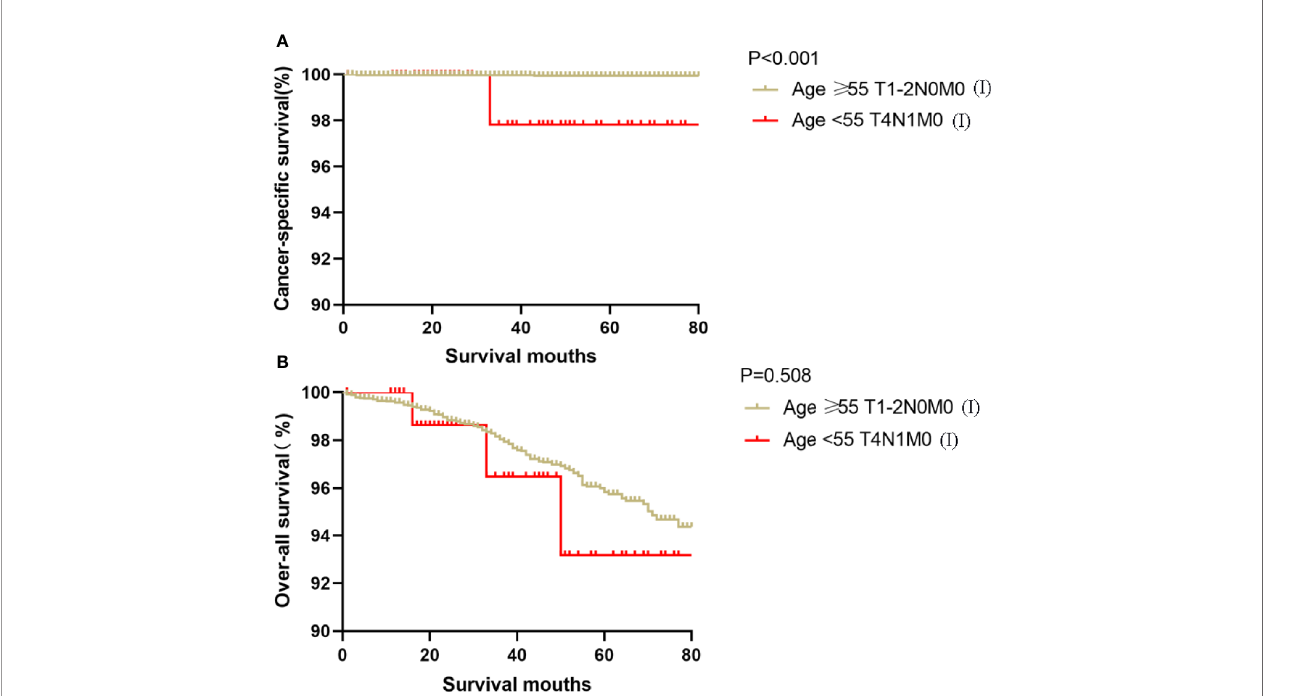
FIGURE 3 | Kaplan – Meier curves for cancer-speci fi c survival (A) and overall survival (B) between FVPTC patients aged ≥ 55 years with stage T1-2N0M0 disease and patients aged <55 years with stage T4N1M0